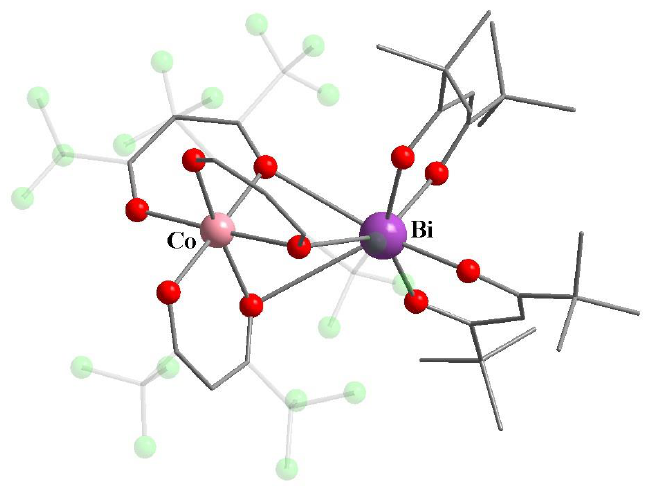
Scheme 9. Synthesis of heteroleptic [Bi(III)-M(II)] complexes ( 20 – 22 ).